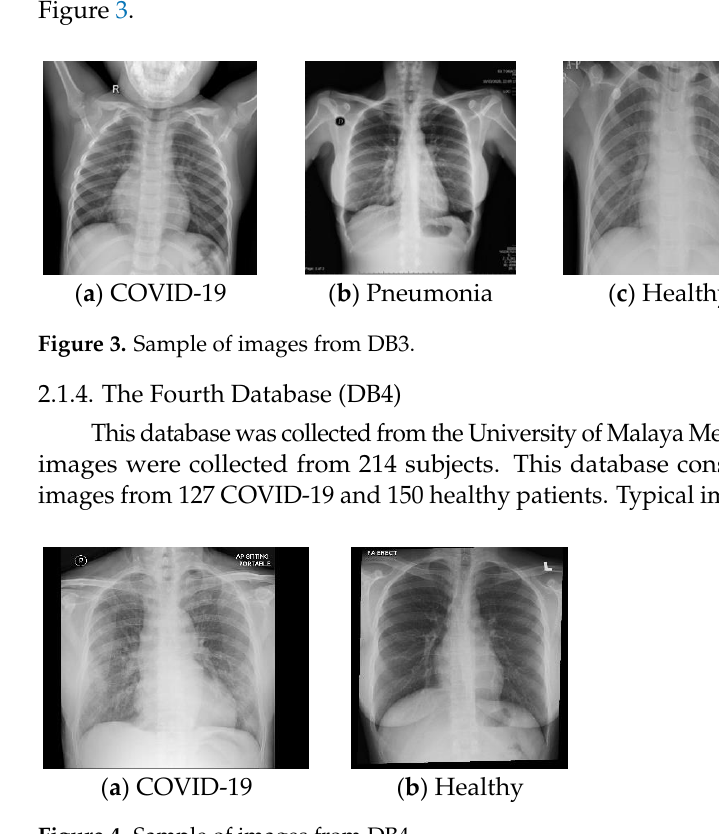
Figure 4. Sample of images from DB4.